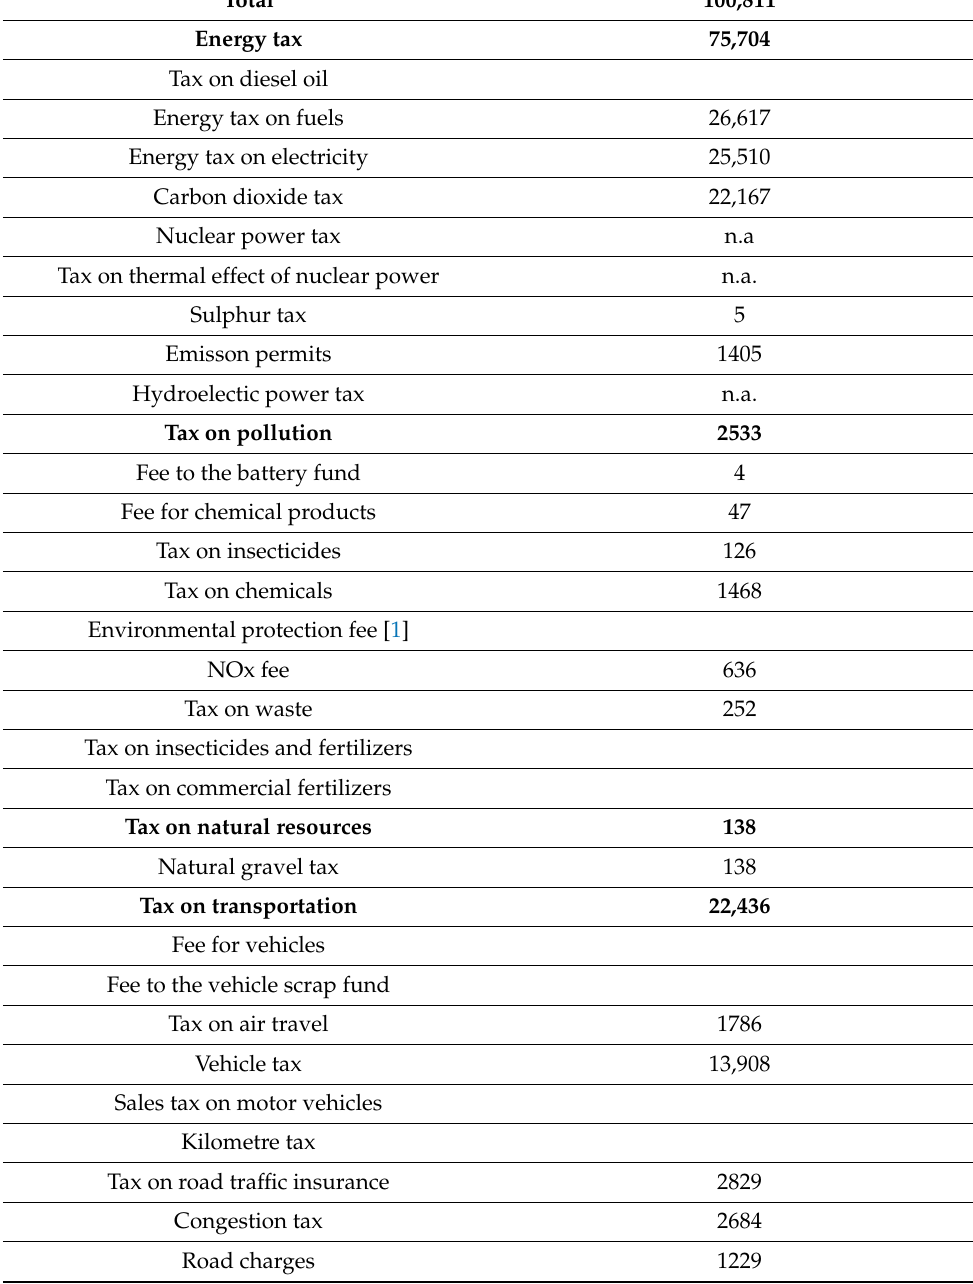
Table 9. Green taxes (revenue) for Sweden (2019). (Million Swedish Kronas). Source: Statistics Sweden